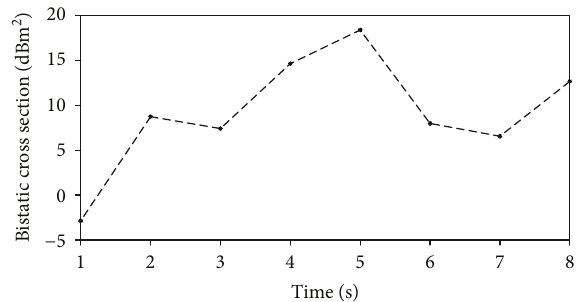
Figure 17: Coherent cumulative averaging values of cuboid candles by means of MIMO